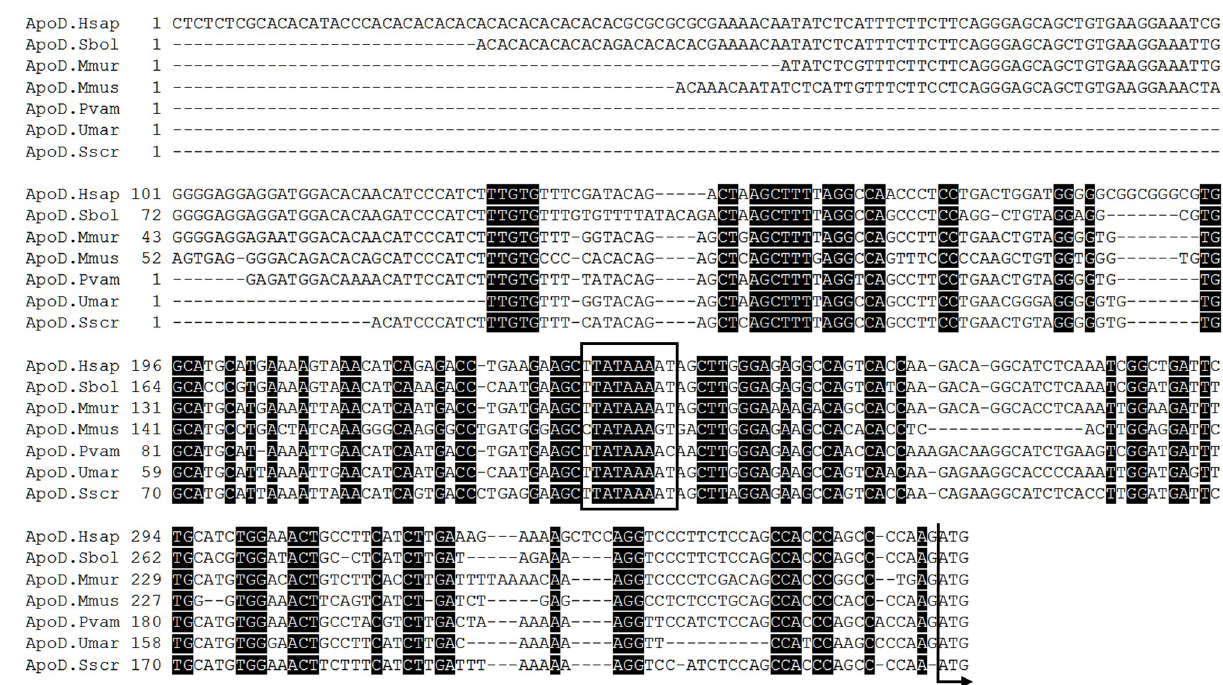
Fig 1. Evolutionary conservation of ApoD 5’ UTR in mammals. Multiple sequence alignment of the RefSeq 5’ UTRs of several mammalian species. Nucleotide sequence identity across all taxa are highlighted in black. A conserved TATA box is marked by a square, and the beginning of the CDS is pointed by an arrow. Hsap: Homo sapiens (primates); Sbol: Saimiri boliviensis (primates); Mmur: Microcebus murinus (primates); Mus musculus (rodentia); Pvam: Pteropus vampyrus (chiroptera); Umar: Ursus maritimus (carnivora); Sscr: Sus scrofa (artiodactyla).